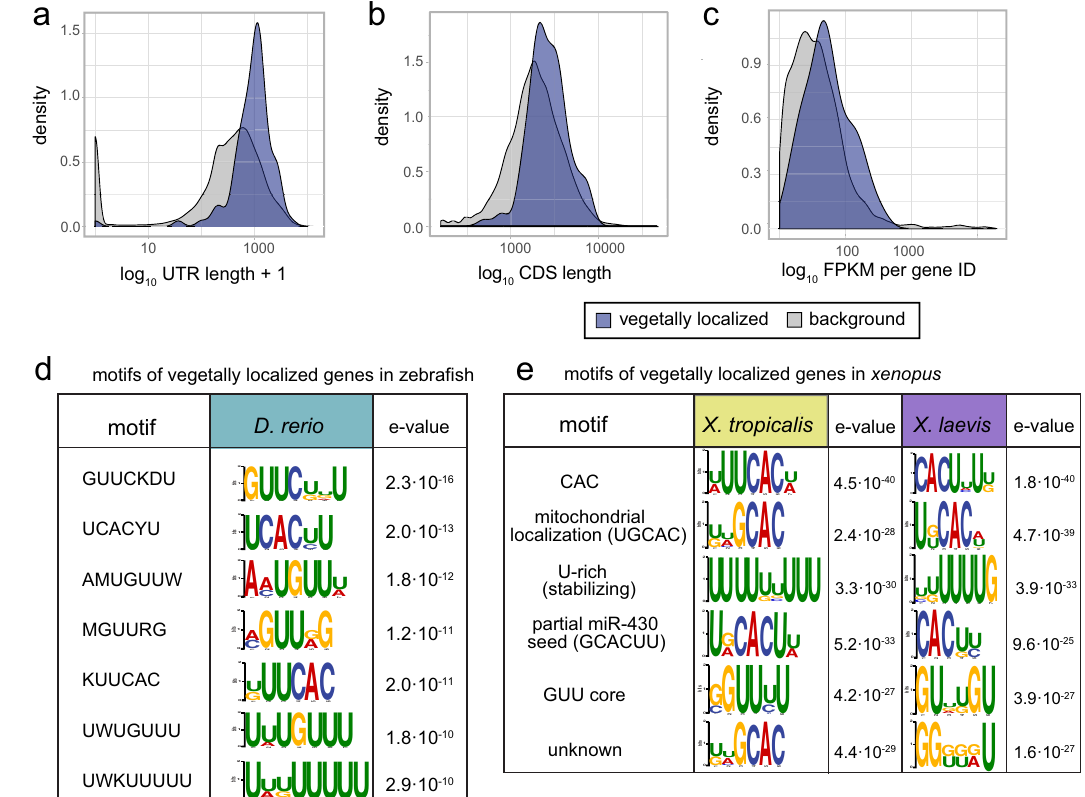
Fig. 6 3 ′ UTR characteristics of vegetally localized genes. a – c Comparison of sequence characteristics of expressed isoforms of vegetally localized to all genes. a Weighted 3 ′ UTR (untranslated region) lengths: isoforms contribute according to their relative expression, mean(vegetal genes) = 1.06 kb, mean (background) = 0.6 kb, p value < 2.2 × 10 − 16 (two-sample Wilcoxon test). b Weighted lengths of coding sequences (CDS), mean(vegetal genes) = 2.78 kb, mean(background) = 2.42 kb, p value = 7.655 × 10 − 14 (two-sample Wilcoxon test). c FPKM (fragments per kilobase of transcript per million mapped reads) sum per gene ID, IDs with <10 FPKM were omitted. Mean expression of vegetal genes 64.1 FPKM, mean of background 37.4, p value < 2.2 × 10 − 16 , (two-sample Wilcoxon test). d Results of the k -mer enrichment analysis of 3 ′ UTRs of 216 expressed isoforms, zebra fi sh vegetally localized genes. Top seven motifs and logos. e Results of the k -mer enrichment analysis of the longest 3 ′ UTR of vegetally localized genes in X. laevis and X. tropicalis , top six motifs, and their respective description based on previous